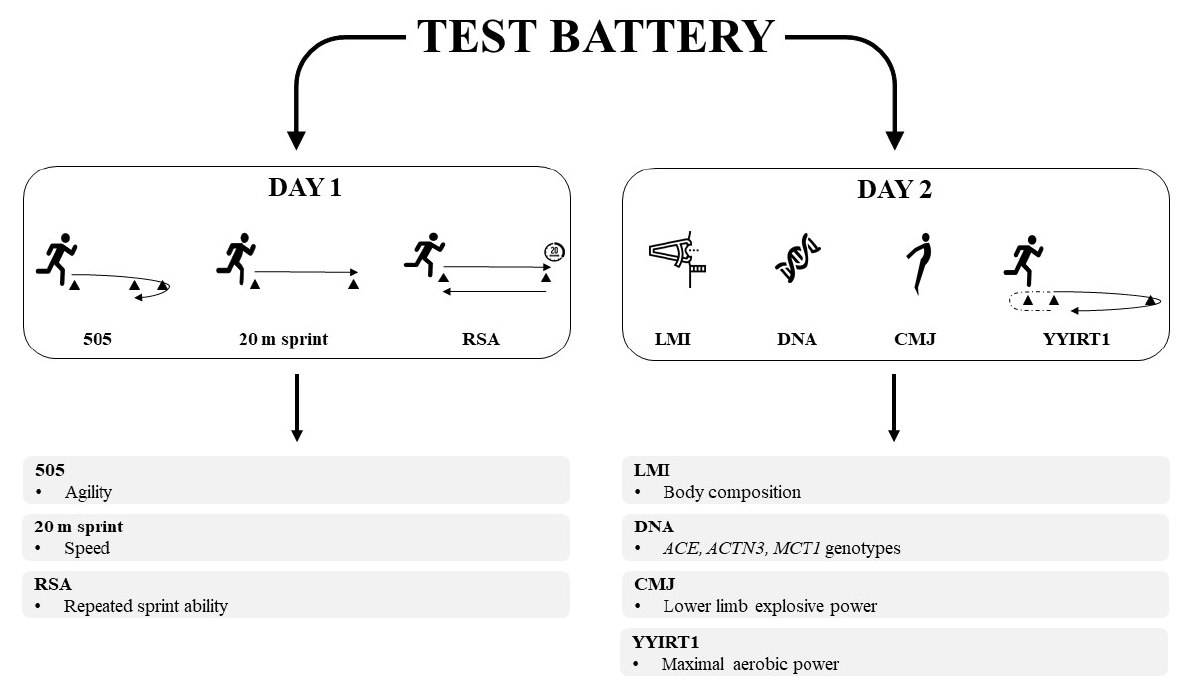
Figure 1. Design of the test battery.